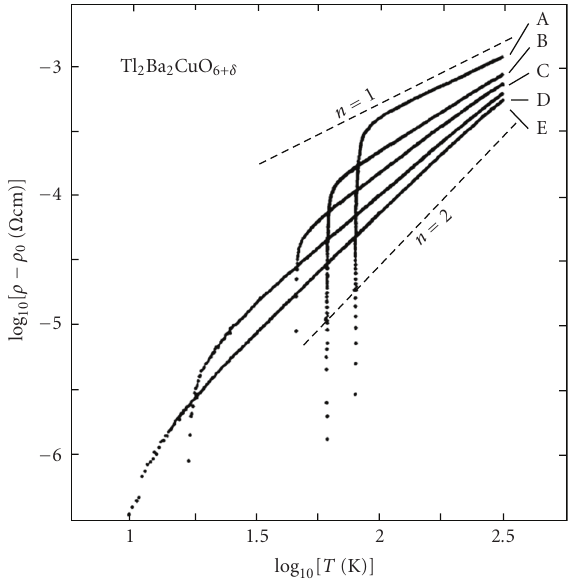
Figure 6: From [30], fit of the resistivity ρ of Tl 2 Ba 2 CuO 6+ δ to a power law temperature dependence ρ = ρ o + AT n shown on a log- log scan. The dashed lines indicate the slope for n = 1 and n =